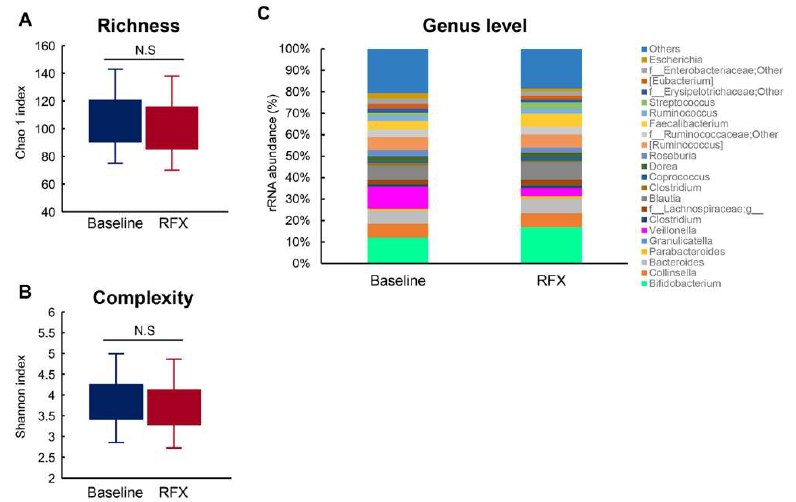
Figure 4. Fecal microbial analysis. ( A ) There was no statistically significant di ff erence in the richness (Chao1 index) between the baseline and after rifaximin treatment groups. ( B ) There was no statistically significant di ff erence in the complexity (Shannon index) between the baseline and after rifaximin treatment groups. ( C ) Taxonomic composition of fecal bacterial communities in the genus level. The relative abundance of Veillonella was decreased after 4 weeks of treatment with rifaximin, while the other genera were